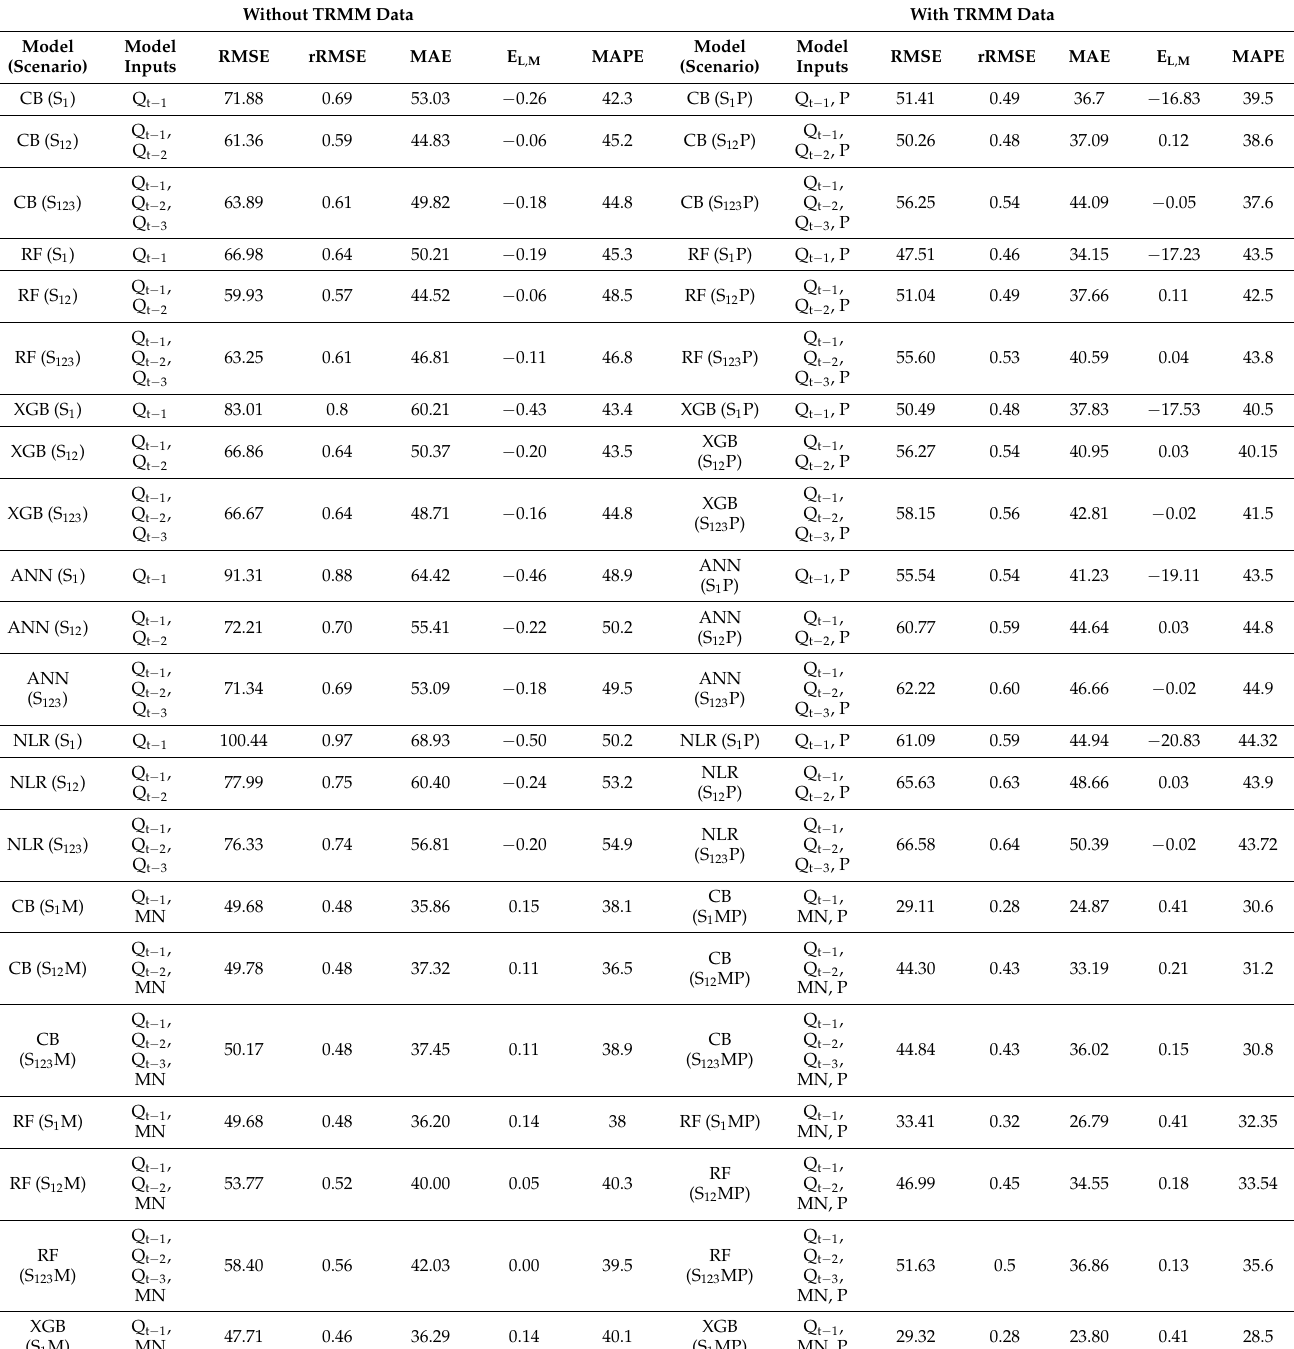
Table 4. Accuracies of the CB, RF, XGB, ANN and NLR methods in predictions of monthly streamflow at the Kale Station (Code: 1402) in the testing